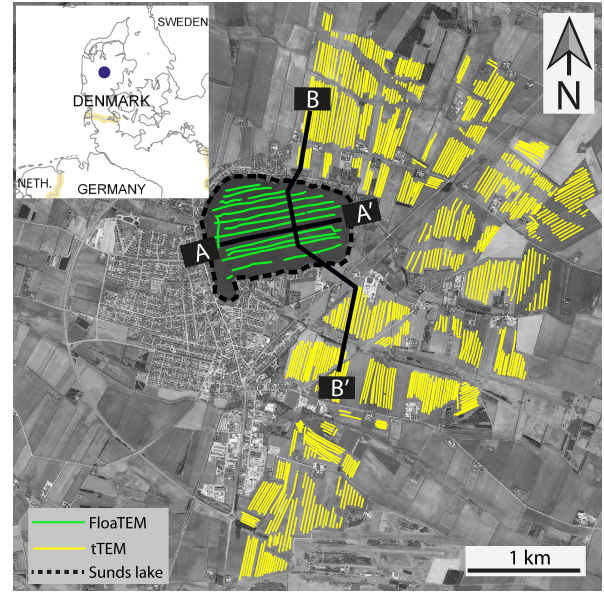
Figure 4. Sunds FloaTEM and tTEM survey region with FloaTEM lines marked in green and tTEM in yellow. AA (cid:48) and BB (cid:48) are the profiles that are presented in Fig.